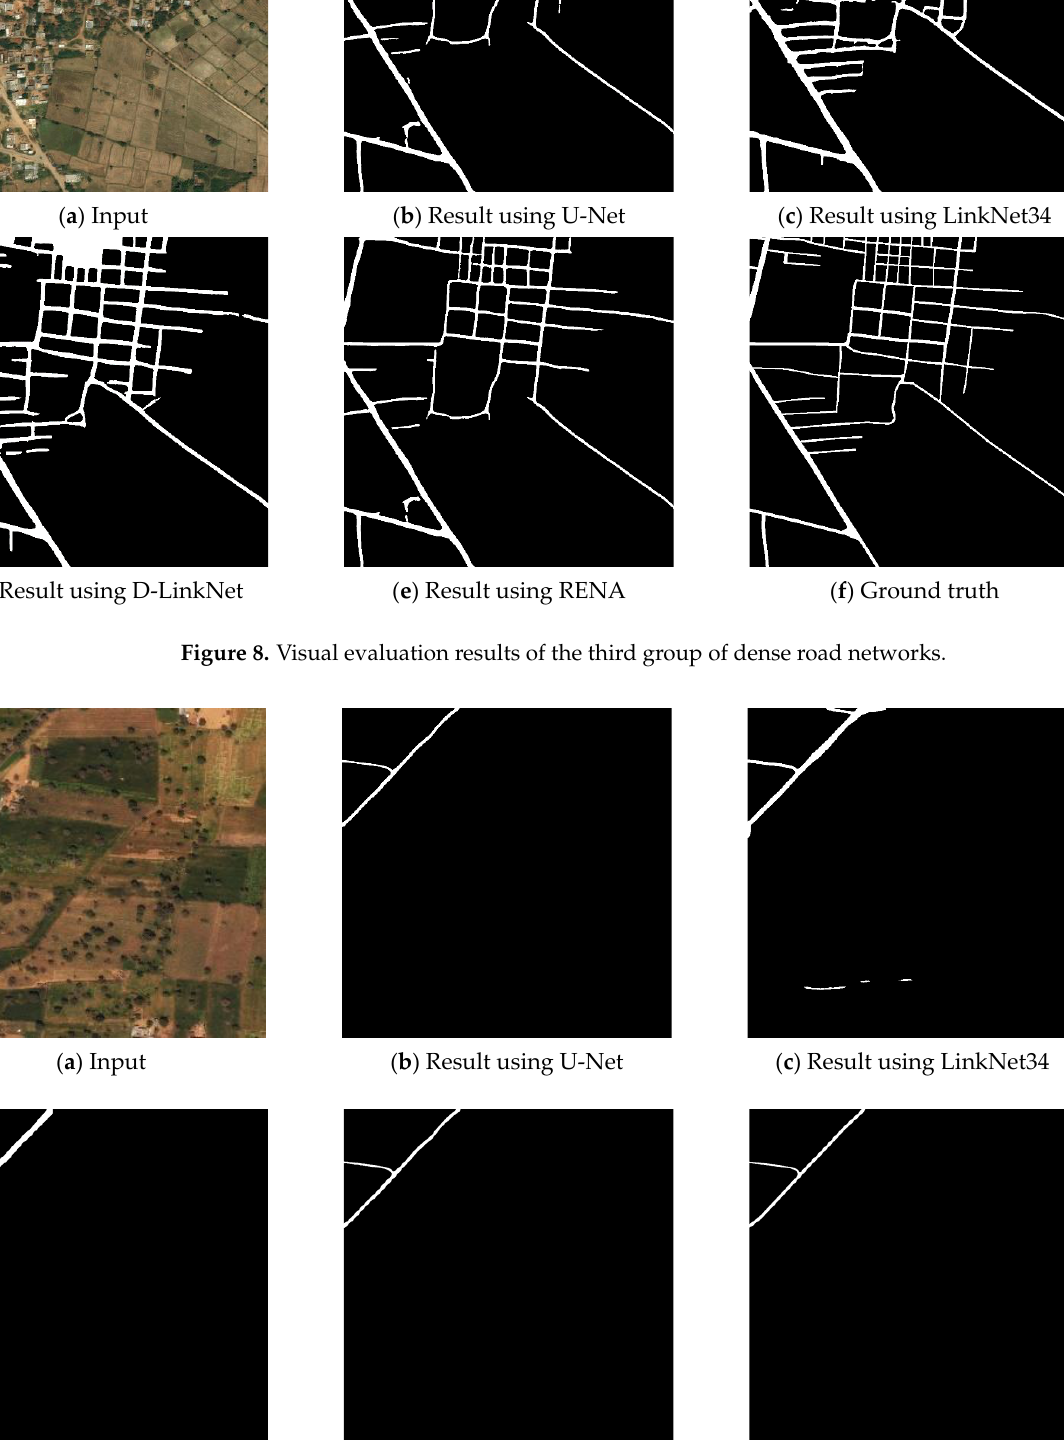
Figure 8. Visual evaluation results of the third group of dense road networks.